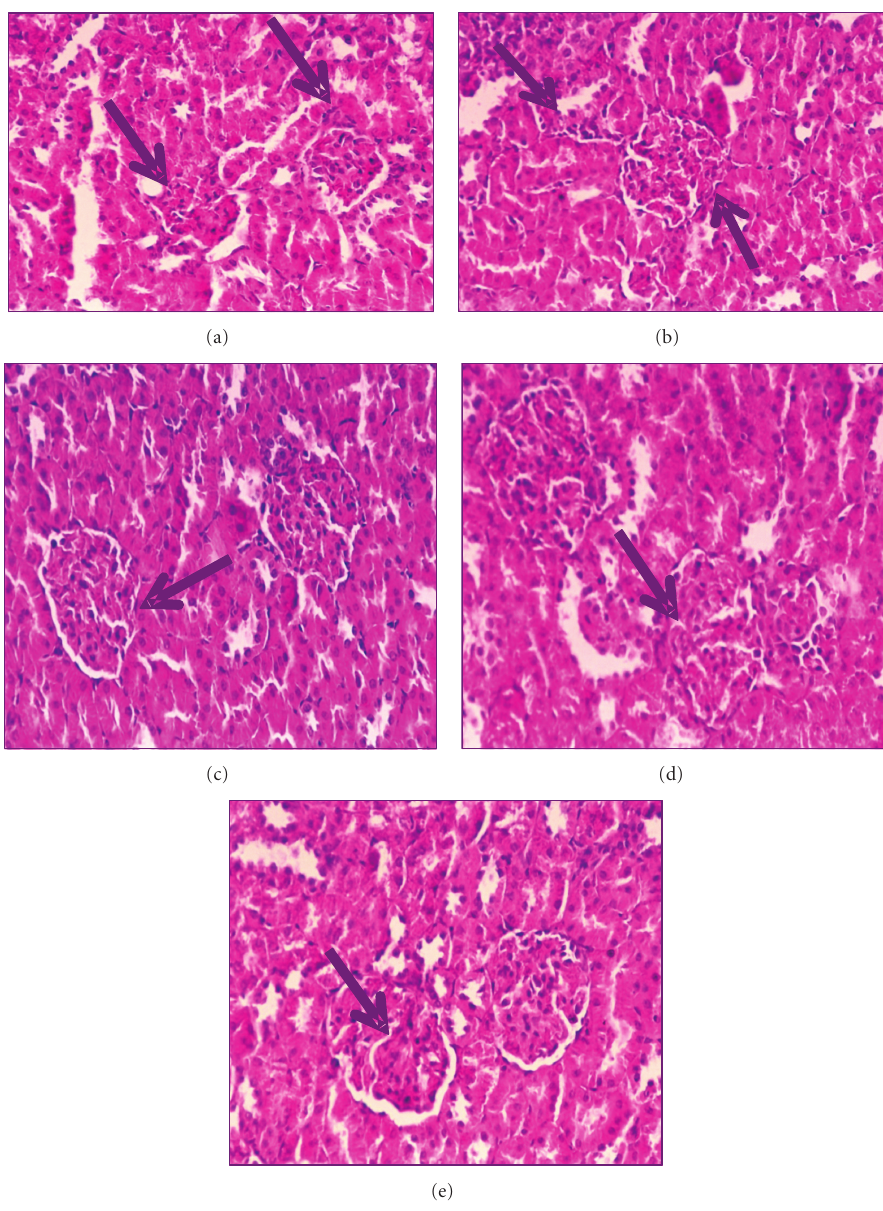
Figure 6: Photomicrography of kidney sections (200x) of CCl 4 (a), CCl 4 treated with ethanol extract (b), CCl 4 treated with chloroform extract (c), CCl 4 treated with petroleum ether extract (d), and CCl 4 treated with silymarin (e) stained with haematoxylin and eosin. Table 1: E ff ect of petroleum ether, chloroform, ethanol extracts, and silymarin drug treatment on histopathological examination of rats kidney exposed to CCl 4 .